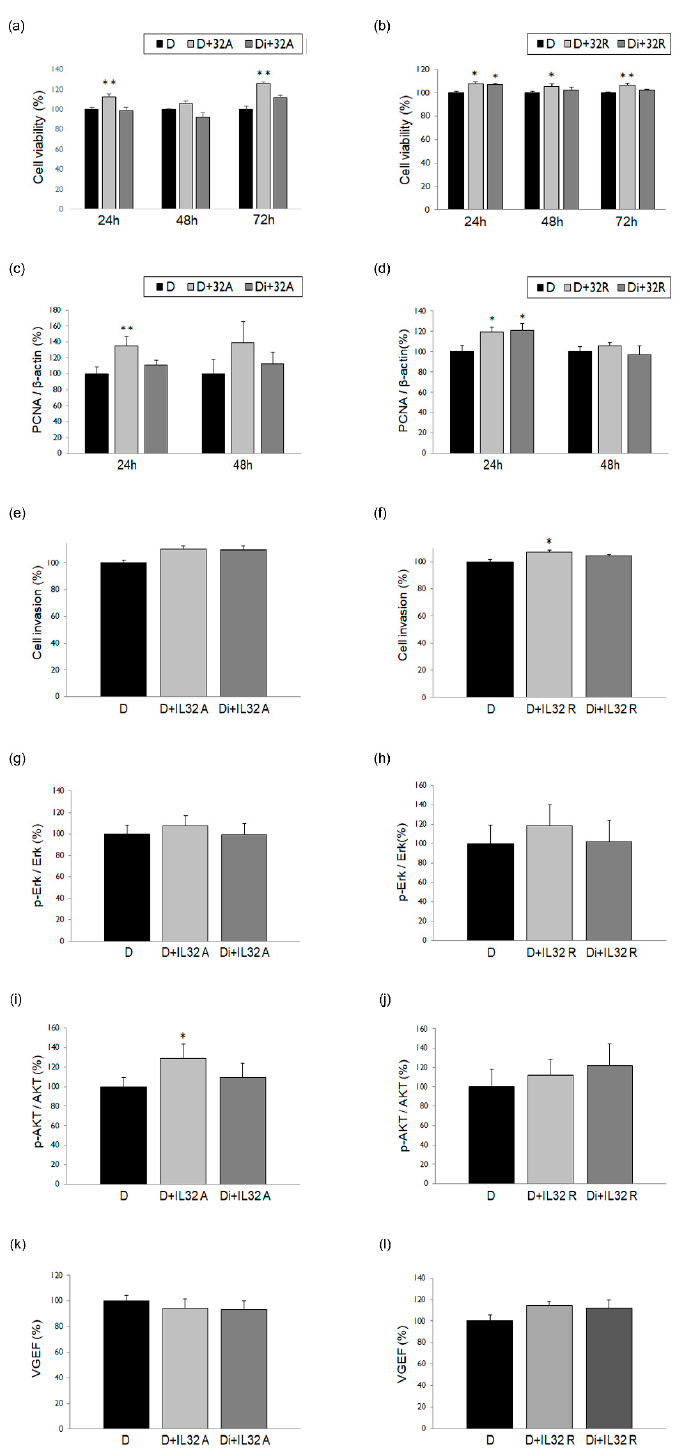
Figure 4. Effect of DNG treatment with IL-32 α or IL-32 γ on human ESCs. Cell viability, expression of PCNA, cell invasion, ERK and AKT phosphorylation, and VEGF expression following IL-32 α ( a , c , e , g , i , k ) or IL-32 γ ( b , d , f , h , j , l ) treatment alone or in combination with DNG in ESCs. Error bars show the mean ± SEM. * p < 0.05 versus control, ** p < 0.05 versus control as well as with both DNG and IL-32 α / γ treatments in ESCs. D = ESCs in DMSO solution (control); D + 32A/D + 32R = treated with IL-32 α /IL-32 γ (25 ng/mL); Di + 32A/Di + 32R = treated with DNG 10 − 6 M and IL-32 α /IL-32 γ (25 ng/mL). Data are expressed as a percentage, wherein cells treated with the vehicle are normalized to